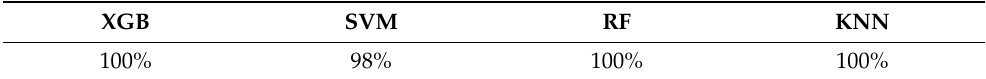
Table 8. Classification report (validation) of different machine learning models for detection of hawkweed flowers at 0.65 cm/pixel. Matrix RF SVM KNN XGB Precision (%) 100 100 100 100 Recall (%) 100 98 100 100 Hawkweed flowers F 1 score (%) 100 99 100 100 Precision (%) 100 98 100 100 Background Recall (%) 100 100 F 1 score